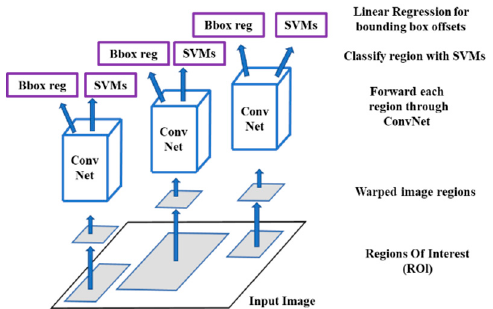
Figure 8. Flow of Regions – Convoluted Neural Network (R-CNN).